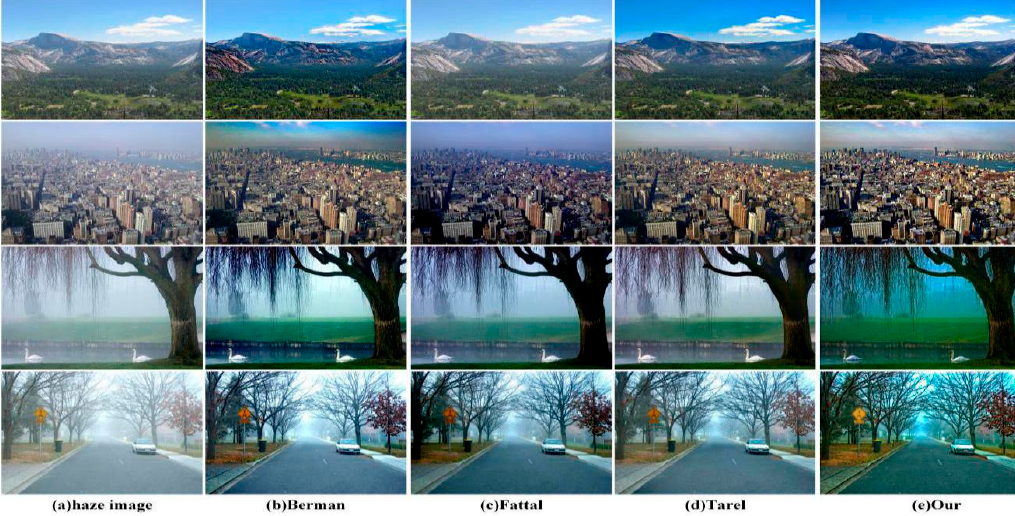
Figure 11. A comparison in detail recovery.